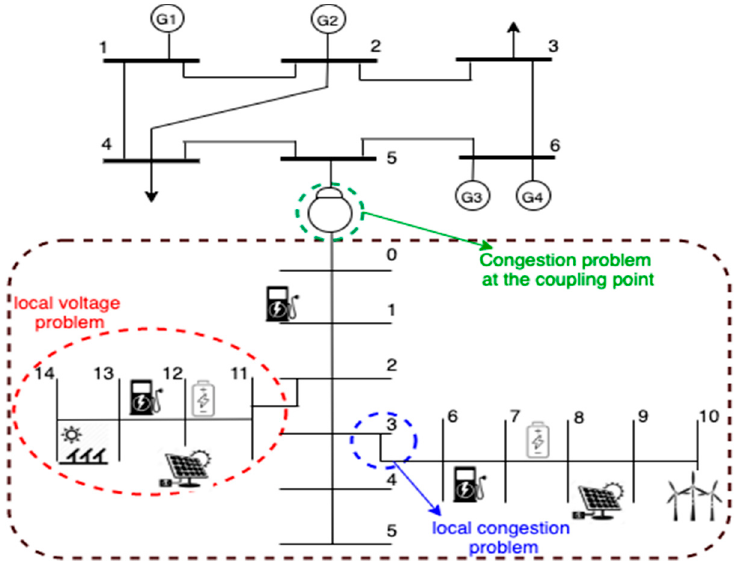
Figure 1. System